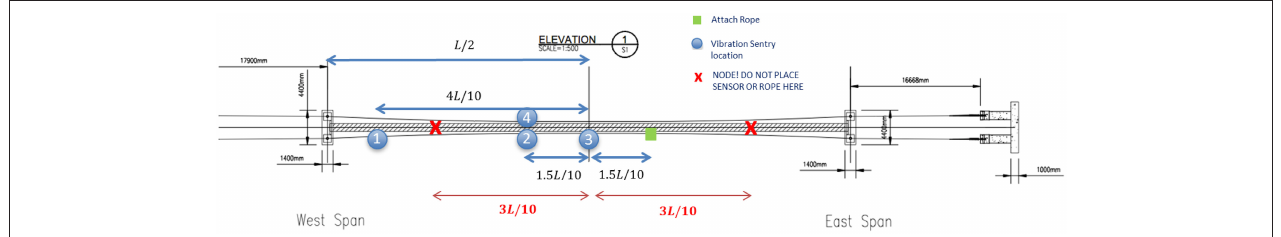
FIGURE 2 | A schematic diagram of sensor